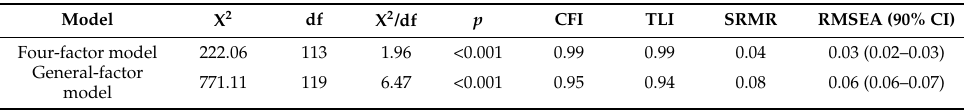
Table 6. Fit indices for the two models ( n =